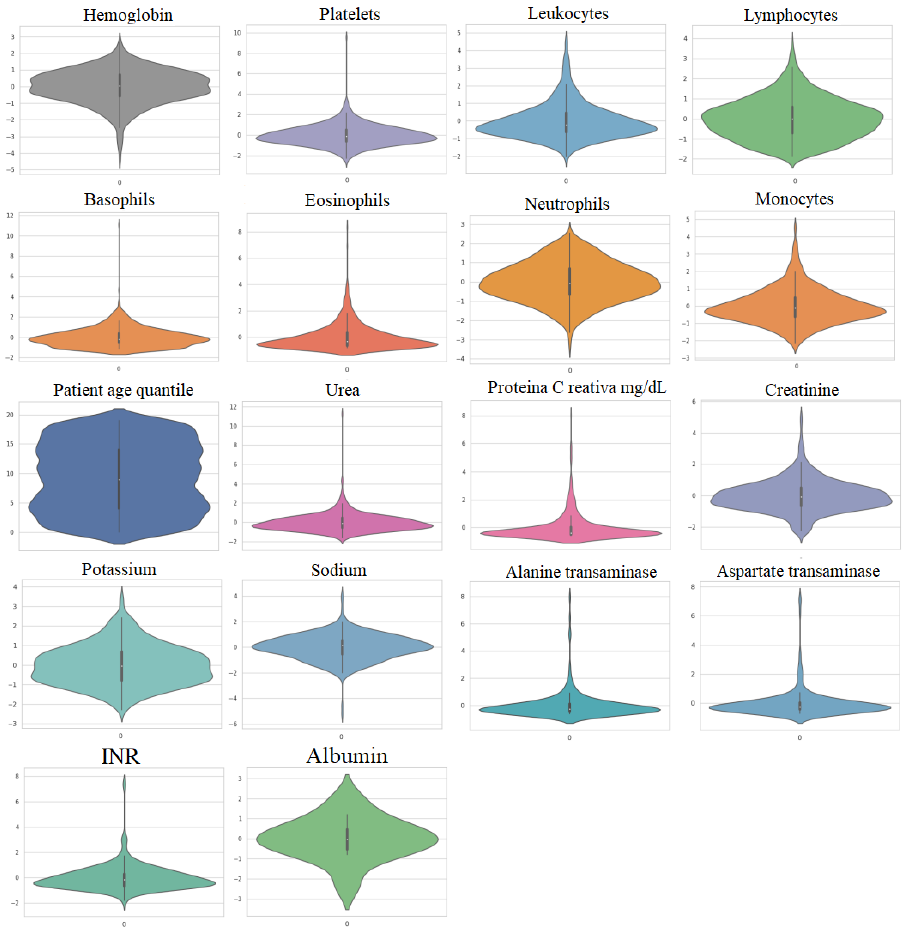
Figure 2. Violin plots of the utilized features in Dataset 1.